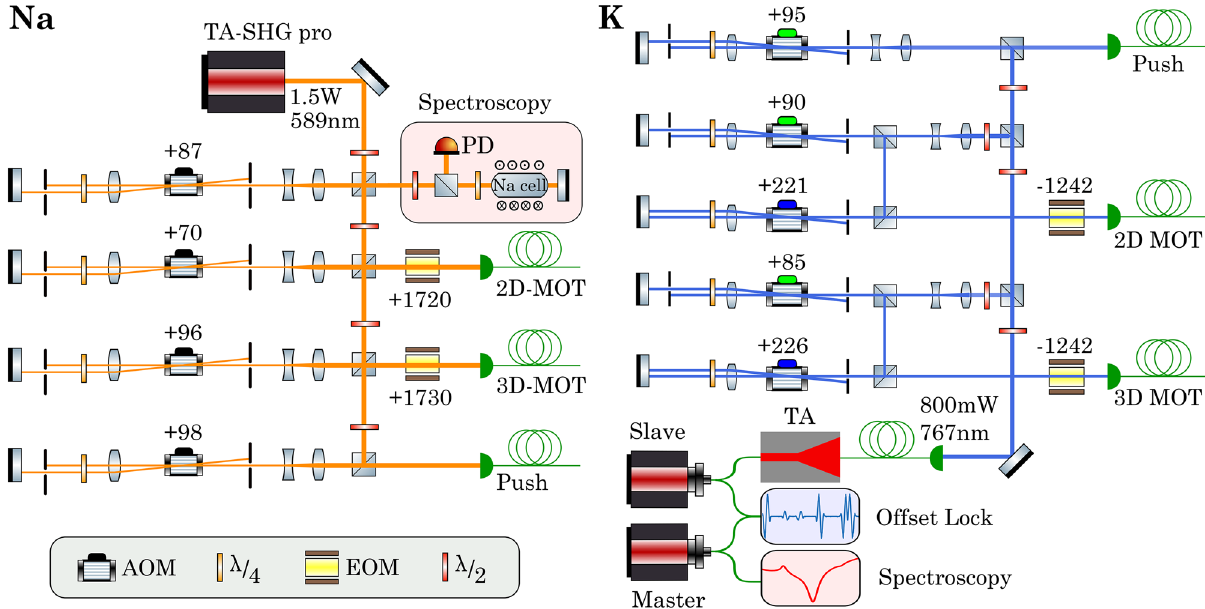
Figure 3. Sketch of the optical setup for laser cooling of sodium and potassium atoms. The laser light is split into different paths, enabling the individual control of laser power and frequency for the 2D-MOT,